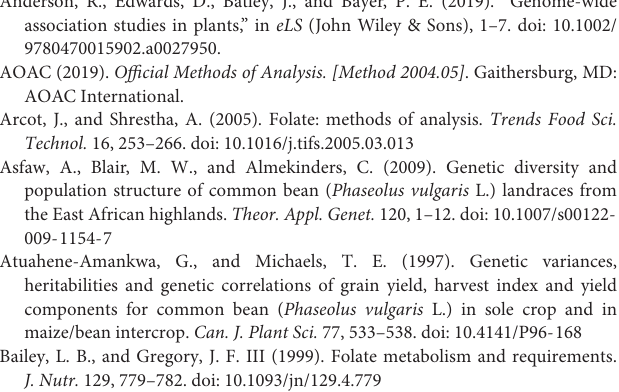
Supplementary Figure 1 | Distribution of SNP markers on the 11 chromosomes of P. vulgaris . Chromosomes are colored based on SNP density (see legend). Supplementary Figure 2 | Bayes cluster plot of 96 P. vulgaris accessions when K = 6. Variational Bayesian inference was implemented in fastSTRUCTURE. Five runs were performed for each K from 1 to 12, and the change in the log probability of the data between successive K values (delta K test) was used to determine the most likely value of K = 6. Each vertical line represents an accession, and multicolored lines indicate admixture between populations.